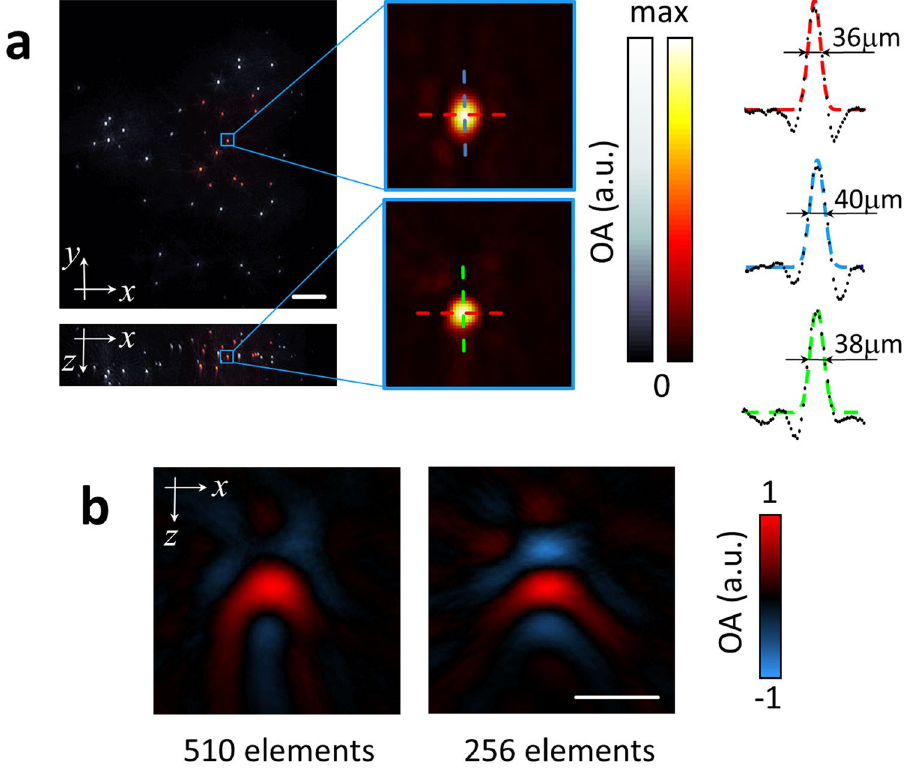
Figure 2. Spatial resolution characterization. ( a ) Maximum intensity projections of the 3D images reconstructed from a single position of the spherical array (‘hot’ colormap) and reconstruction obtained with raster-scanning of the array (‘bone’ colormap). Scalebar – 1 mm. 1D profiles through a single reconstructed sphere (zoom-in is shown in ( a )) are shown for the x (red), y (blue) and z (green) directions. Colored curves represent Gaussian fits. ( b ) Cross-sections of the reconstructed microsphere located at approximately the center of the transducer array when considering all 510 transducer elements covering 180° angle (left) versus the 256 inner elements covering ~90° angle (right). Scalebar – 100 μ